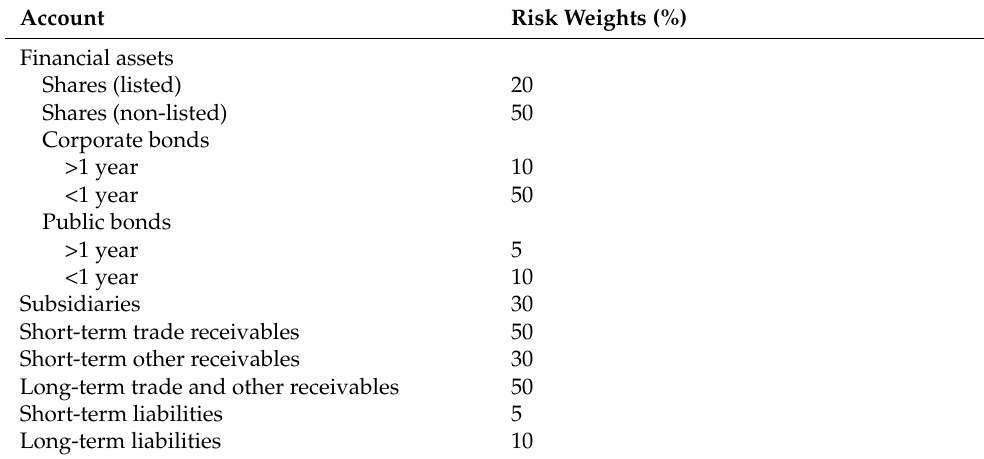
Table 4. Calculated risk weights of assets for securities